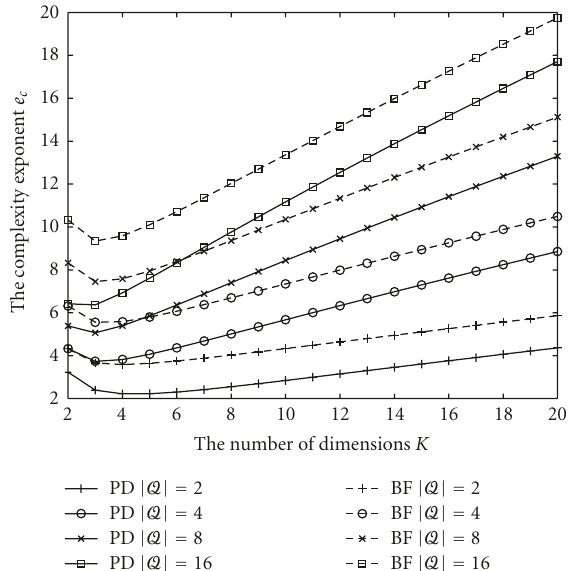
Figure 8: The complexity exponent as a function of K for various | Q | and SNR = 15 dB. PD refers to planar detection and BF refers to exhaustive ML